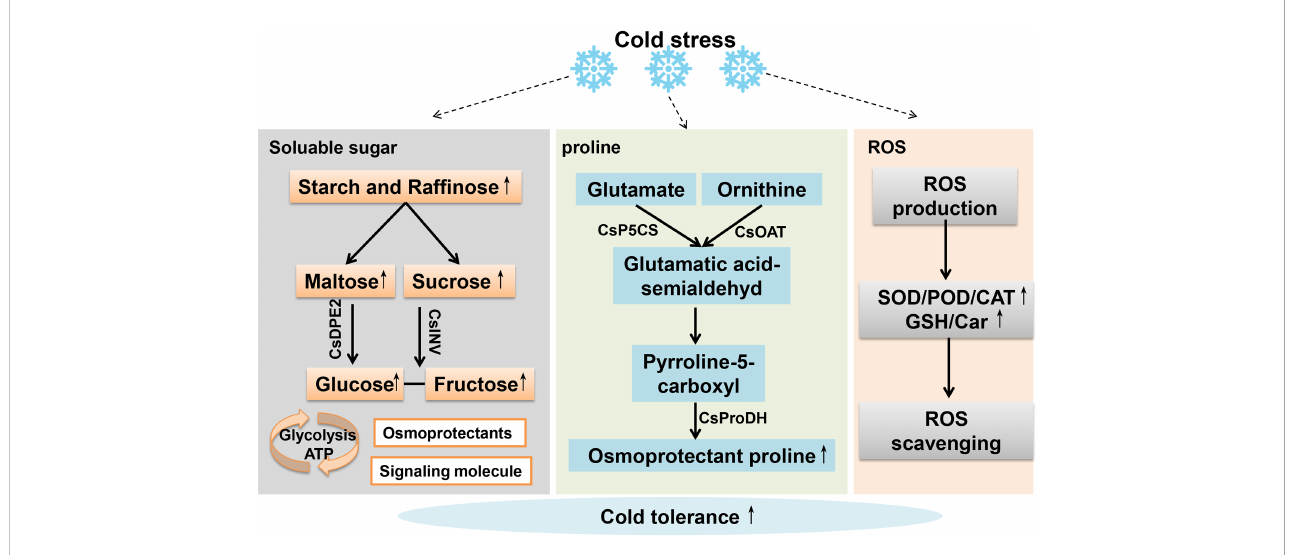
FIGURE 1 The alternation of some metabolisms of tea plants during cold